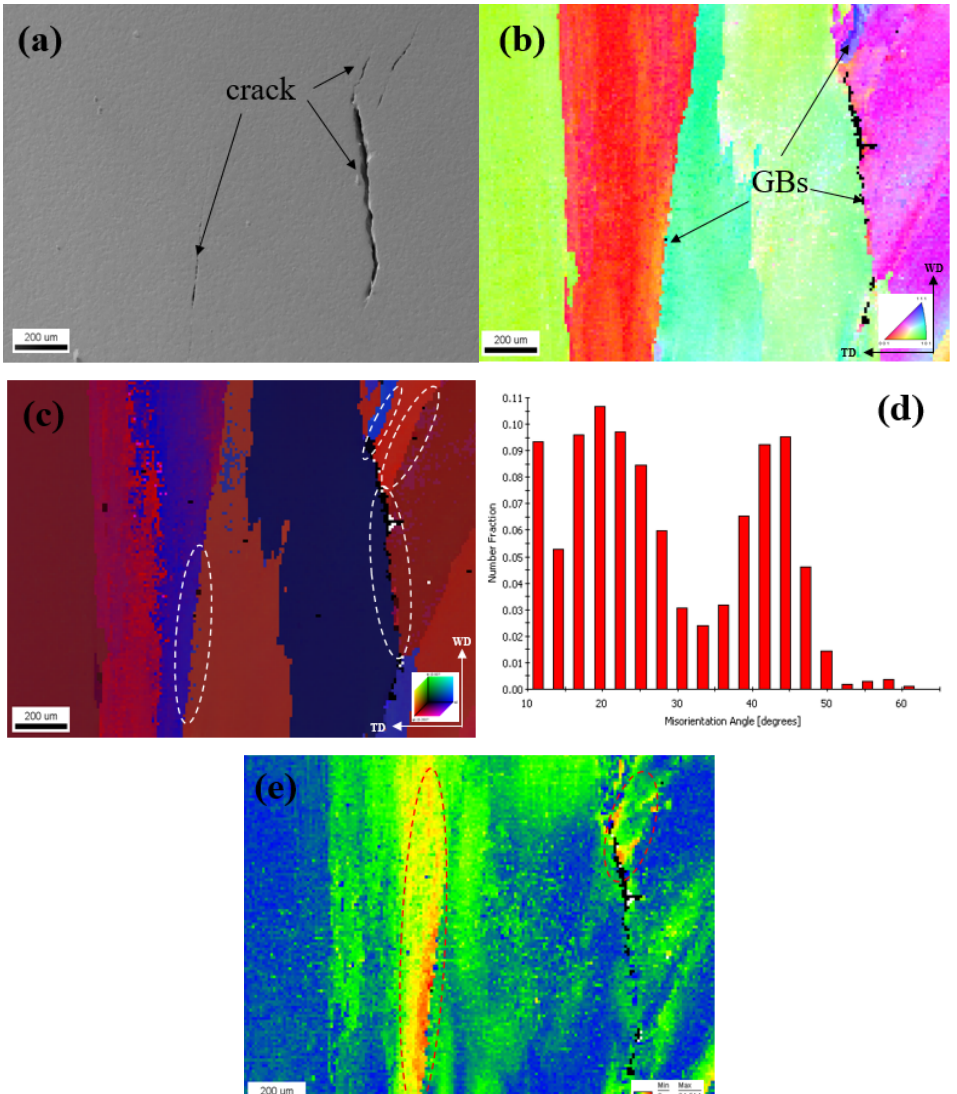
Figure 8. Micro-morphology and EBSD results of DDC in nickel-based alloys: ( a ) secondary electron morphology, ( b ) inverse pole diagram IPF, ( c ) Euler angle RGB distribution diagram, ( d ) grain distribution of orientation difference figure, and ( e ) grain distribution of orientation difference distribution map.